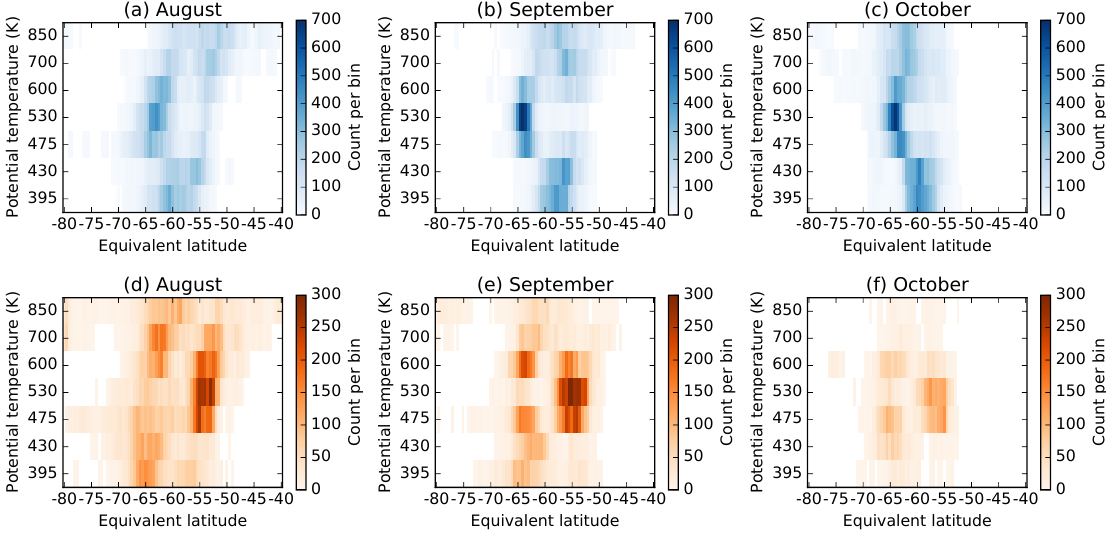
Figure 5. Locations of (a–c) primary and (d–f) secondary peaks in PV gradient at ERA-Interim levels between 395 and 850K, 1979–2016. Peaks are selected using a minimum separation of 5 ◦ and the colour scale shows the number of times that peaks occurred in each 0.5 ◦